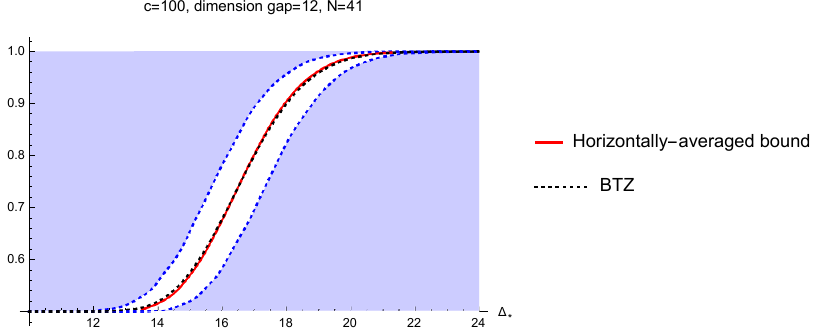
Figure 11 . The horizontal average of the upper and lower bounds on the modular spectral function for c = 100 with dimension gap close to the upper bound imposed by modular